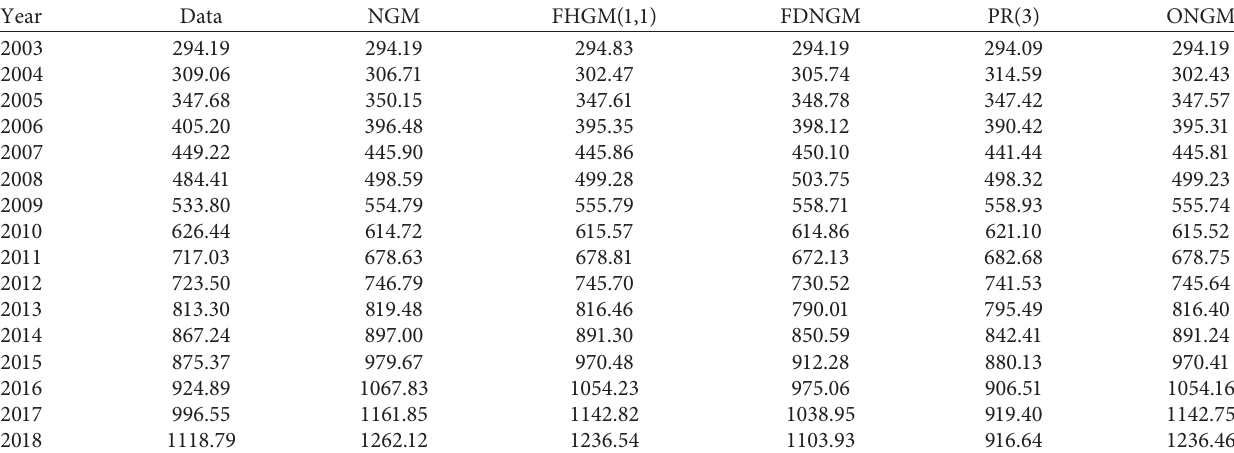
Table 2: The predicted values of original domain by employing the competing models in Case